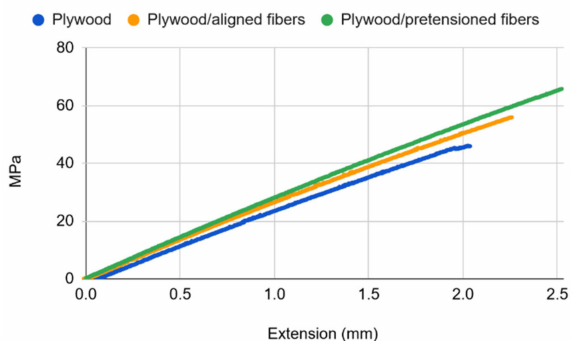
Figure 8. Typical stress-strain relations for plywood and basalt fiber-reinforced plywood at room